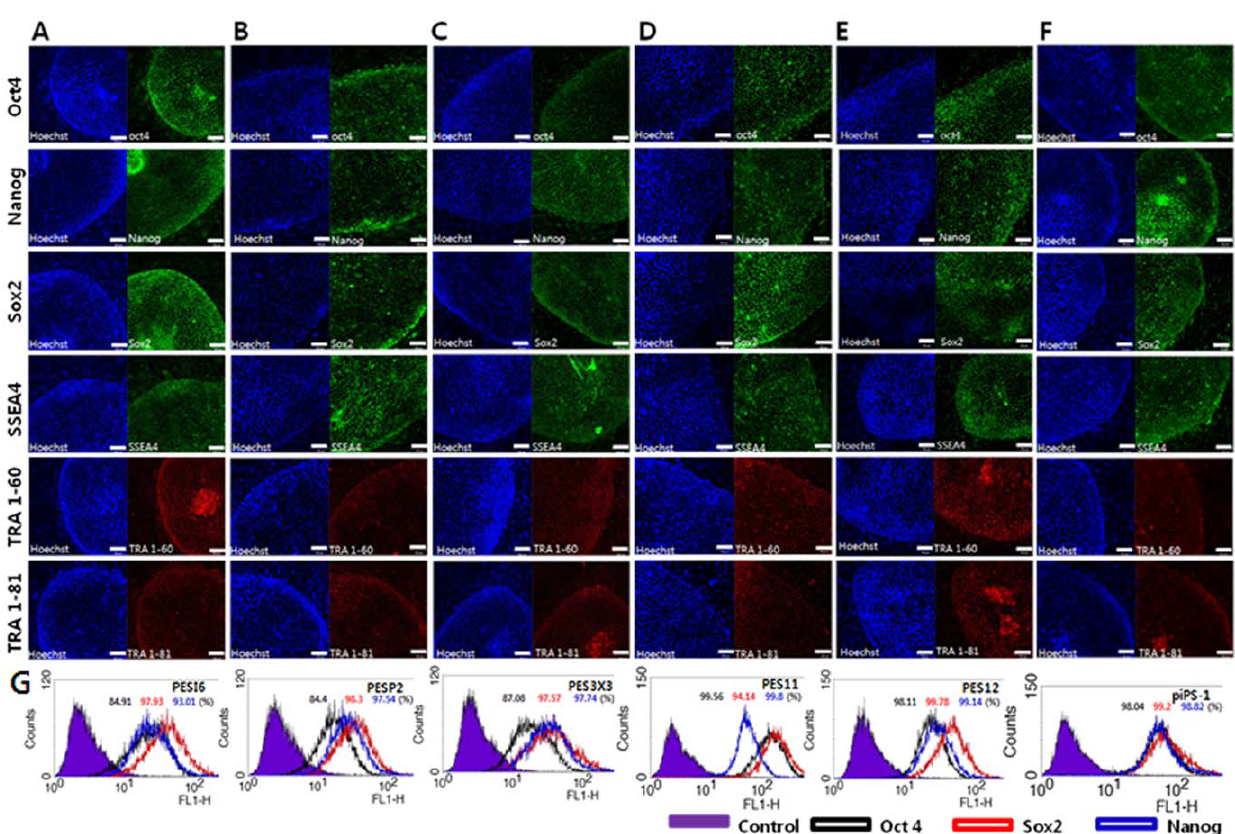
Figure 2. Expression of pluripotent markers in porcine pluripotent cells by immunocytochemistry analysis. Expression of pluripotent markers and surface markers Oct4, Sox2, Nanog, SSEA4, TRA 1–60 and TRA 1–81 was observed all six cell lines ( A ) pESI6, ( B ) pESP2, ( C ) pES3X3, ( D ) pES11, ( E ) pES12 and ( F ) piPS-1. Lanes to the left represent hoechst staining. ( G ) Expression of pluripotent markers Oct4, Sox2 and Nanog was detected in 84.91%, 97.93% and 93.01% of cells from the cell line pESI6, 84.4%, 98.3% and 97.54% in the cell line pESP2, 87.08%, 97.57% and 97.74% in the cell line pES3X3, 99.56%, 94.14% and 99.8% in the cell line pEpiS11, 98.11%, 99.78% and 99.14% in the cell line pES12 and 98.04%, 99.2% and 98.82% in the cell line piPS-1. Scale bars=100 m m.